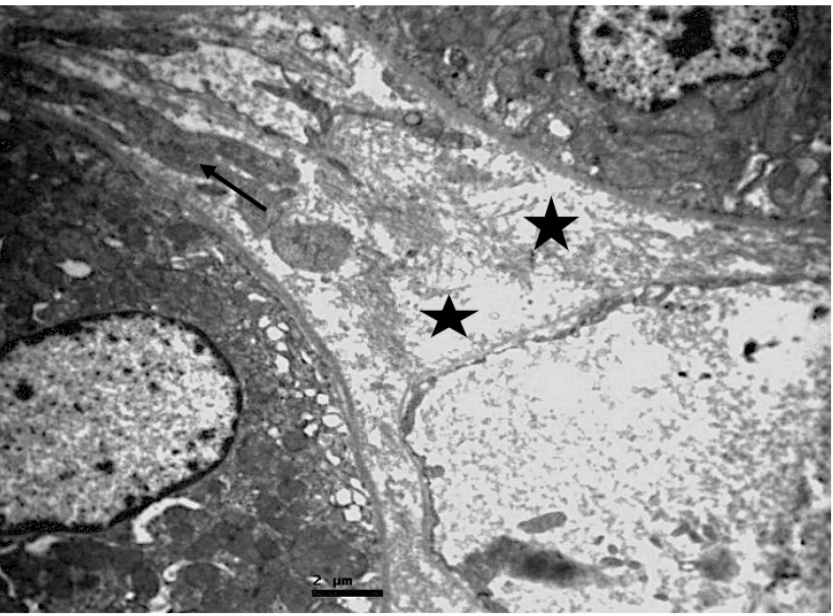
Figure 10. Connective tissue, of resuscitated swine sample that shows edema (black stars) and fibroblasts (black arrow).